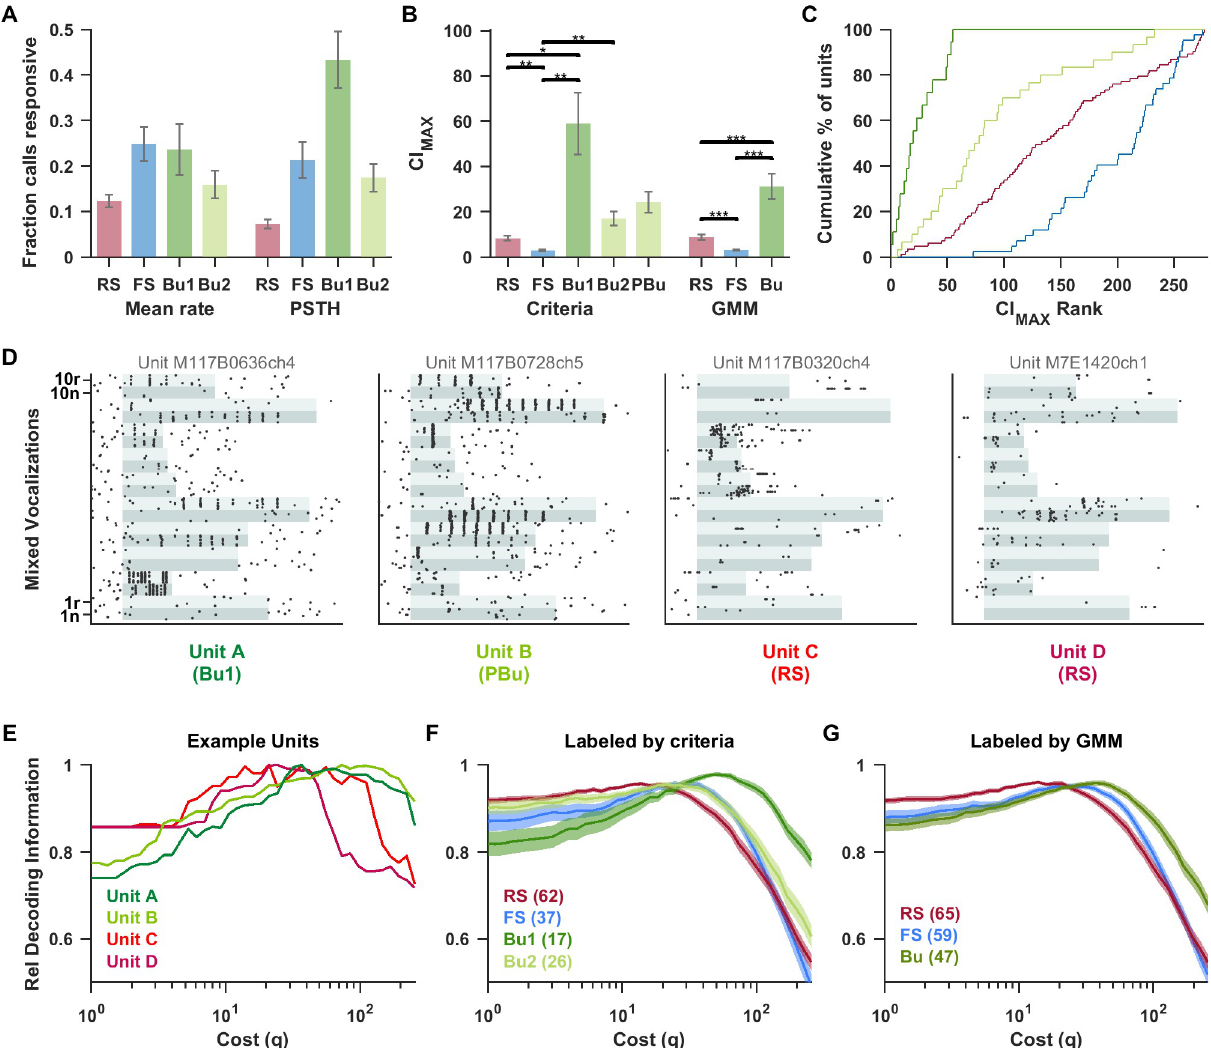
Fig 7. High-frequency bursting neurons spiked in a temporally precise manner in response to vocalizations and better supported a temporal code while RS neurons showed higher rate selectivity. Here, we used responses to a standard “Mixed Vocalizations List” of 20 simple and compound calls (spectrograms shown in S6A Fig). (A) The fraction of call stimuli for which units had an excitatory response (as assessed by overall firing rate or for 5 ms PSTH bins (see Materials and methods). RS units had the highest vocalization selectivity. Bu1 units responded to more stimuli in terms of instantaneous rate change than overall driven rate, reflecting phase-locking. n values are RS (158), FS (50), Bu1 (18), and Bu2 (44). (B) For each unit, the maximum CI across responsive stimuli in the “Mixed Vocalizations List” was considered the CI max . Bu units had the highest CI max values, indicating that they spiked at particular times during the stimulus. The groups (“RS,” “FS,” “Bu1,” and “Bu2”) as labeled by criteria and (“RS,” “FS,” and “Bu”) as labeled by the GMM were each compared with Welch’s ANOVA and found to be highly significant ( F 3,48.9 = 12.5, p < 0.0005 and F 2,90.5 = 22.5, p < 0.0005). “PBu” was not compared. n values for criteria-based categories are: RS (83), FS (42), Bu1 (18), Bu2 (30), PBu (58); and for GMM-based categories are: RS (86), FS (68), and Bu (54). (C) Units were ranked from highest to lowest CI max . The cumulative histogram shows that all Bu1 units had high-ranking CI max values, followed by Bu2, RS, then FS groups. (D) Examples of the vocalization responses of 2 bursting units (intraburst rates 909 and 667 Hz) and 2 RS units to the “Mixed Vocalizations List” (S6A Fig) of natural (“n”) and time-reversed (“r”) vocalization tokens. The stimulus duration is indicated with alternating aqua shading, with each band corresponding to all 10 repetitions of the given stimulus (stimuli were presented in interleaved order). We used the Victor–Purpura distance between spike trains [43] to decode the stimulus from individual trains. A cost parameter ( q ) was varied, spanning from rate coding to temporal coding as q is increased. (E) For the example units in (D), we calculated the transmitted information ( H ) of the confusion matrix as a measure of decoding quality. To better compare the effect of changing q , H is normalized by its maximum value for each unit. The 2 precise bursting units had a higher optimal q range than the RS units. At q = 1, where decoding is close to a rate code, the RS units performed well relative to the bursting units. In contrast, at high q values, decoding performance of RS units falls off steeply while that of high-frequency Bu units persisted. Similar trends are seen for the average of all units labeled by criteria (F) and by the GMM (G). Data underlying this figure can be found in S1 Data. Bu, bursting; CI, correlation index; FS, fast-spiking; GMM, Gaussian mixture model; PSTH, peristimulus time histogram; RS,